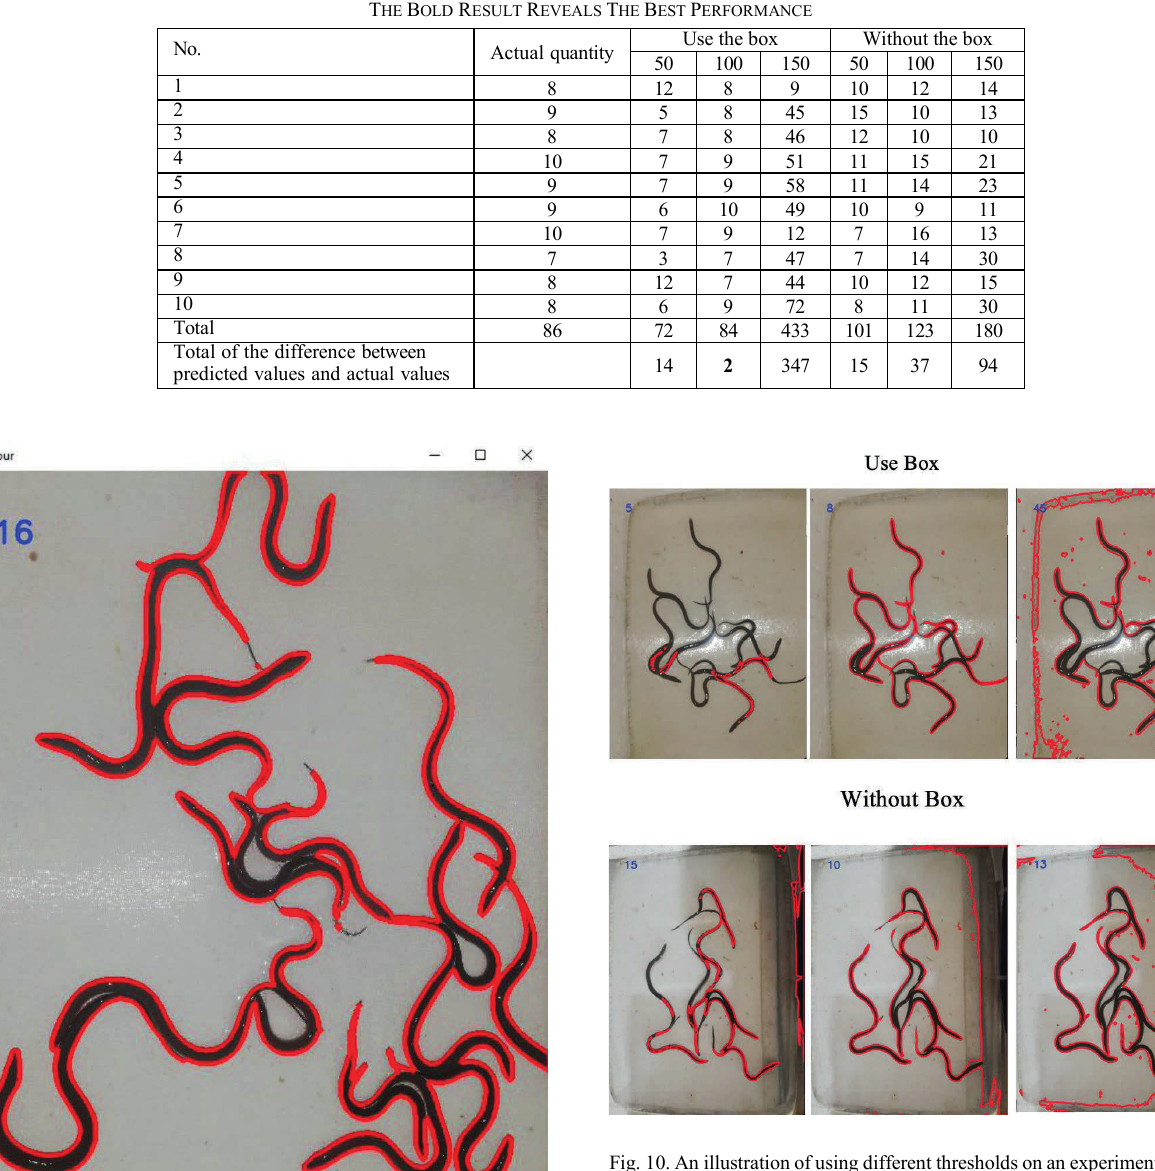
Fig. 10. An illustration of using different thresholds on an experiment time with 9